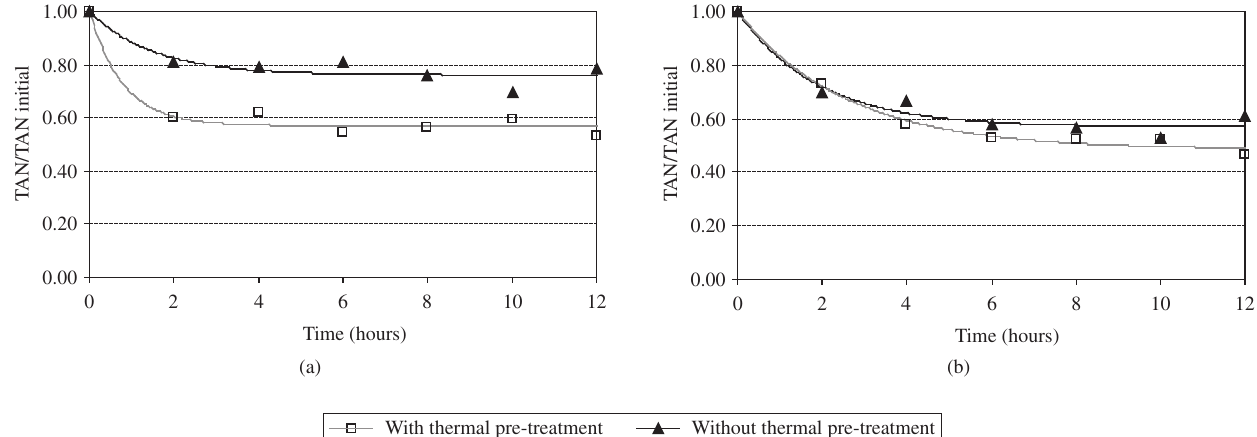
Figure 3. Adsorption kinetics curves. a) TCO 626G clay; and b) Selexsorb CD alumina.